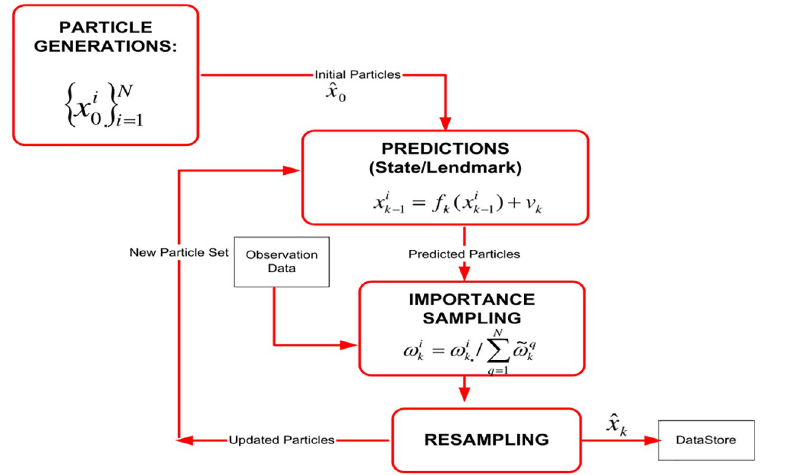
Fig 3. Particle filter based A-SLAM algorithm.